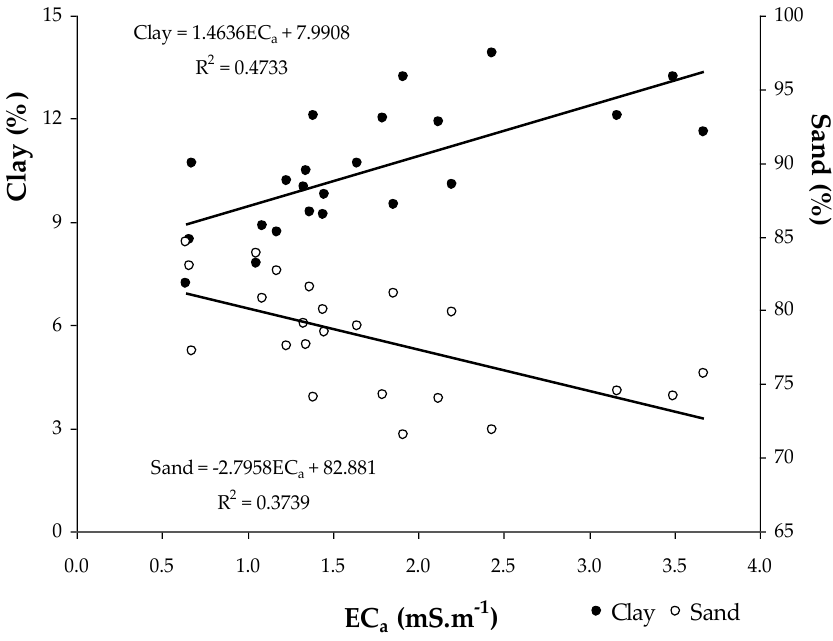
Figure 8. Relationship between soil apparent electrical conductivity (EC a ) and sand and clay content in the 0 – 0.30 m soil layer (2018).